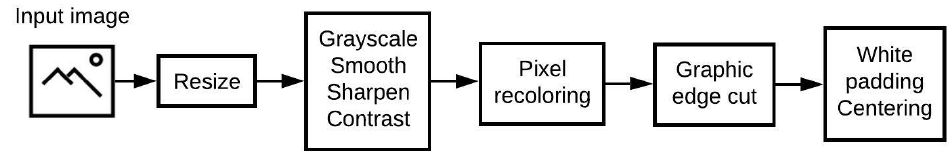
Figure 1. Image pre-processing algorithm.